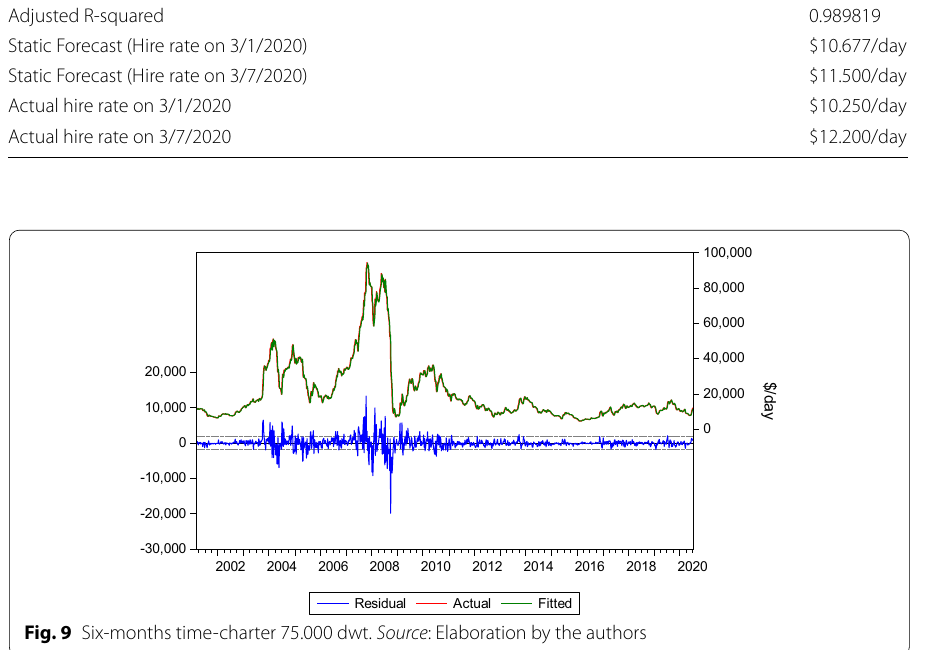
Fig. 9 Six-months time-charter 75.000 dwt. Source : Elaboration by the authors